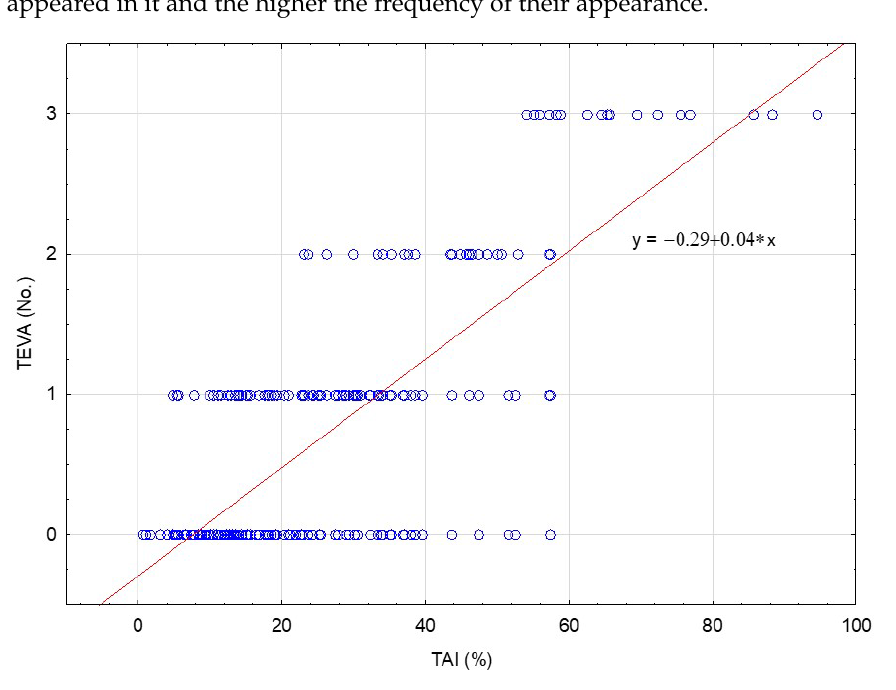
Figure 3. Spearman’s rank correlation between TAI and number of TEVA in the entire group of UDT patients (R = 0.6490, p < 0.001). Red line indicates trend of linearly related variables.